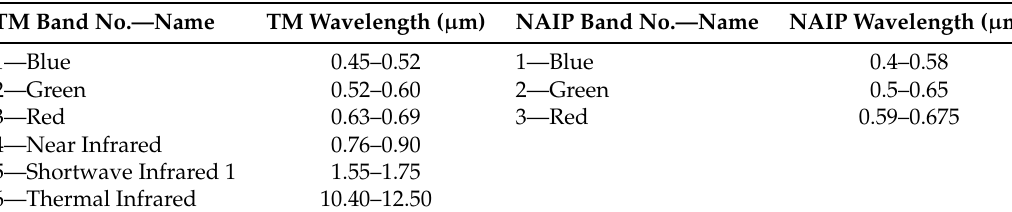
Table 1. Comparison of bands of Landsat TM and NAIP images.